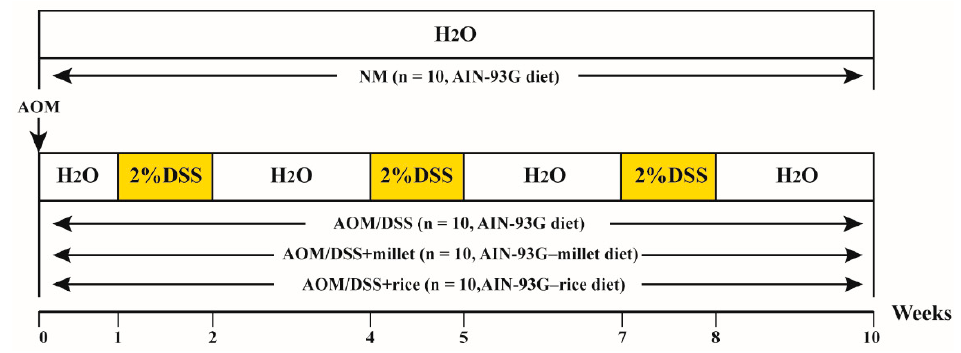
Figure 1. Experimental protocol for the establishment of a murine colitis-associated cancer (CAC) model induced by azoxymethane/dextran sodium sulfate (AOM/DSS). Table 1. Composition of experimental diets.